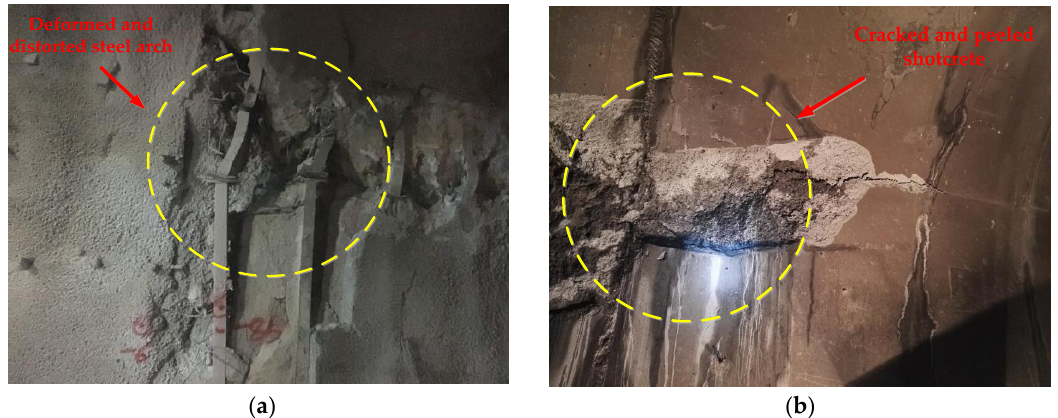
Figure 11. Monitoring results of contact pressure between rock and initial support in Section 1.